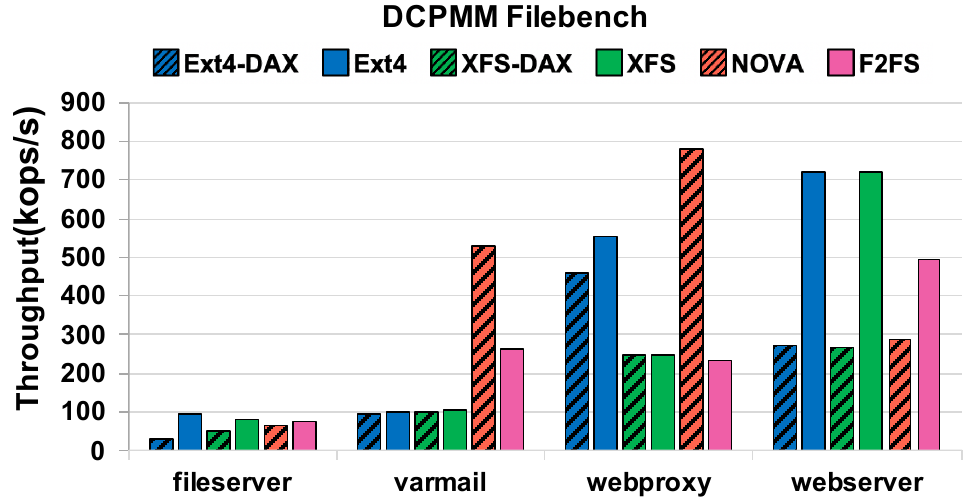
Figure 4. The filebench performance of file systems on